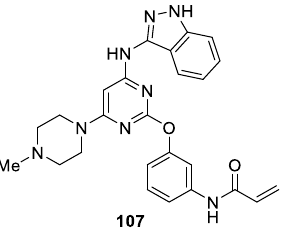
Figure 19. Chemical structure of 1 H -indazole derivative 107 .